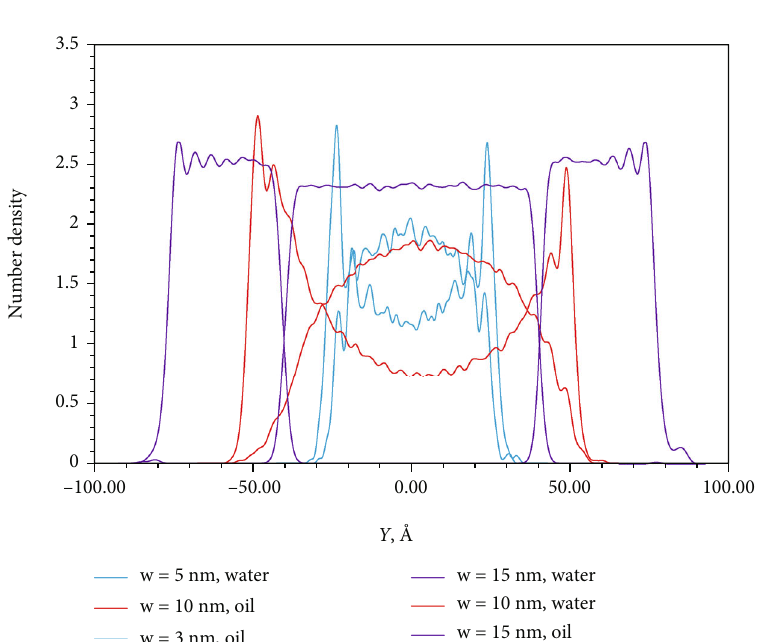
Figure 7: Velocity pro fi le along the Y